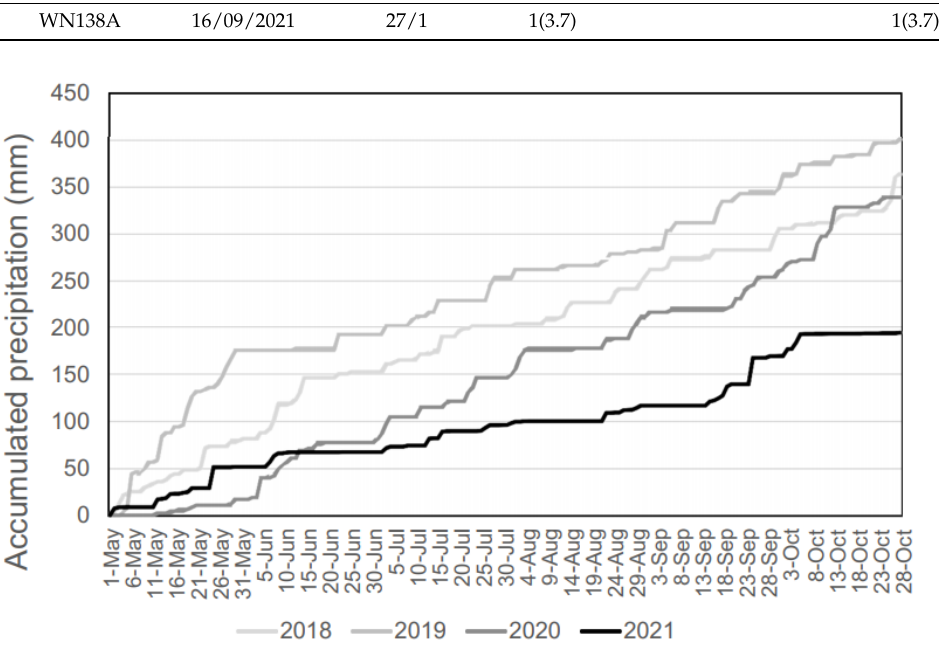
Figure 2. Accumulated precipitation from May to October in the four years of survey in the plain of Emilia-Romagna.